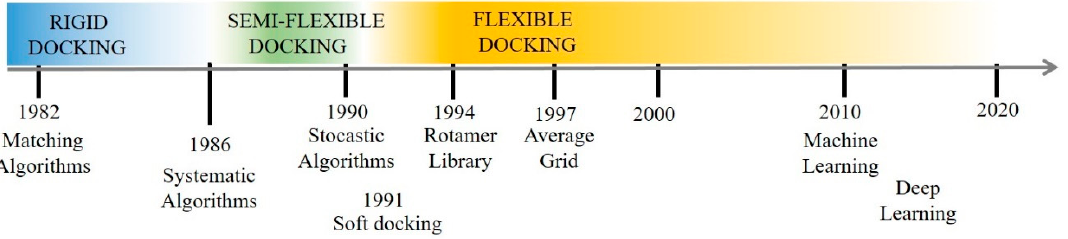
Figure 1. Evolutionary timeline highlighting key events contributing to the development of molecular docking algorithms, starting from rigid to flexible docking.